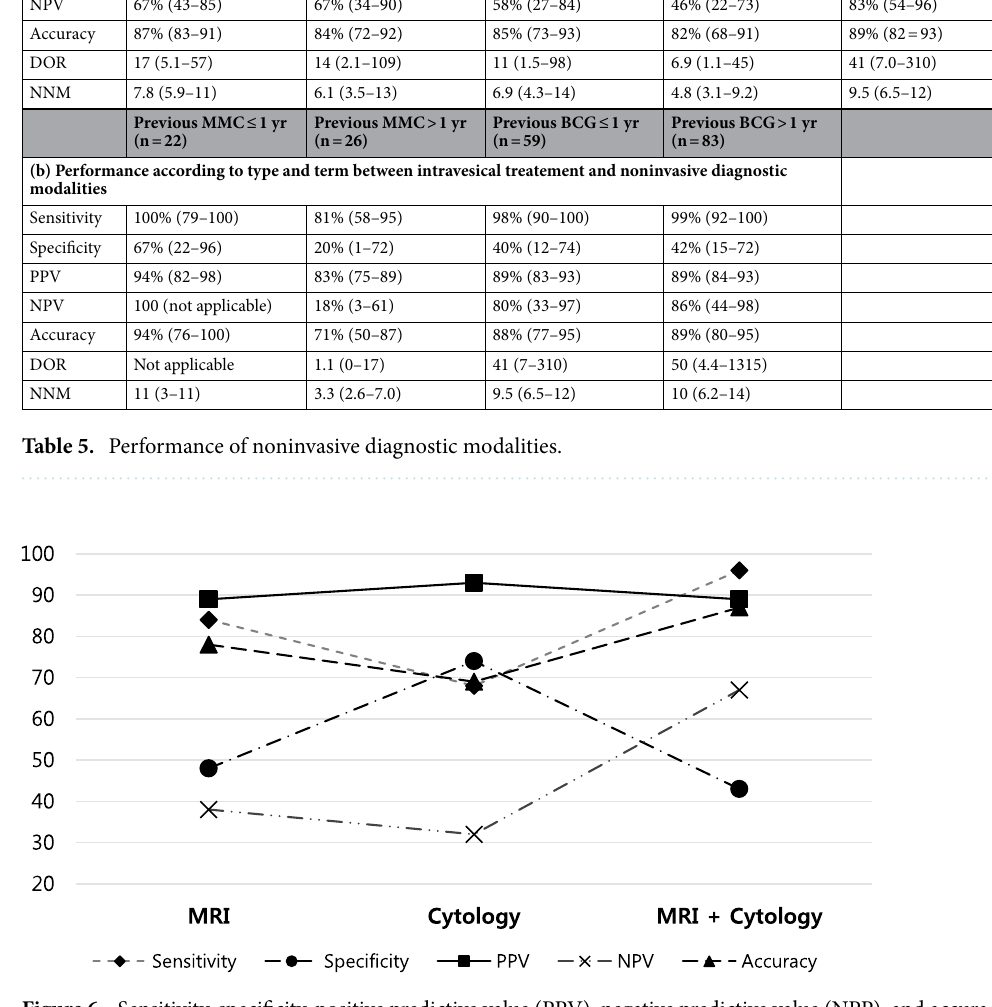
Figure 6. Sensitivity, specificity, positive predictive value (PPV), negative predictive value (NPP), and accuracy of diagnostic modalities for pathologically confirmed bladder cancer.